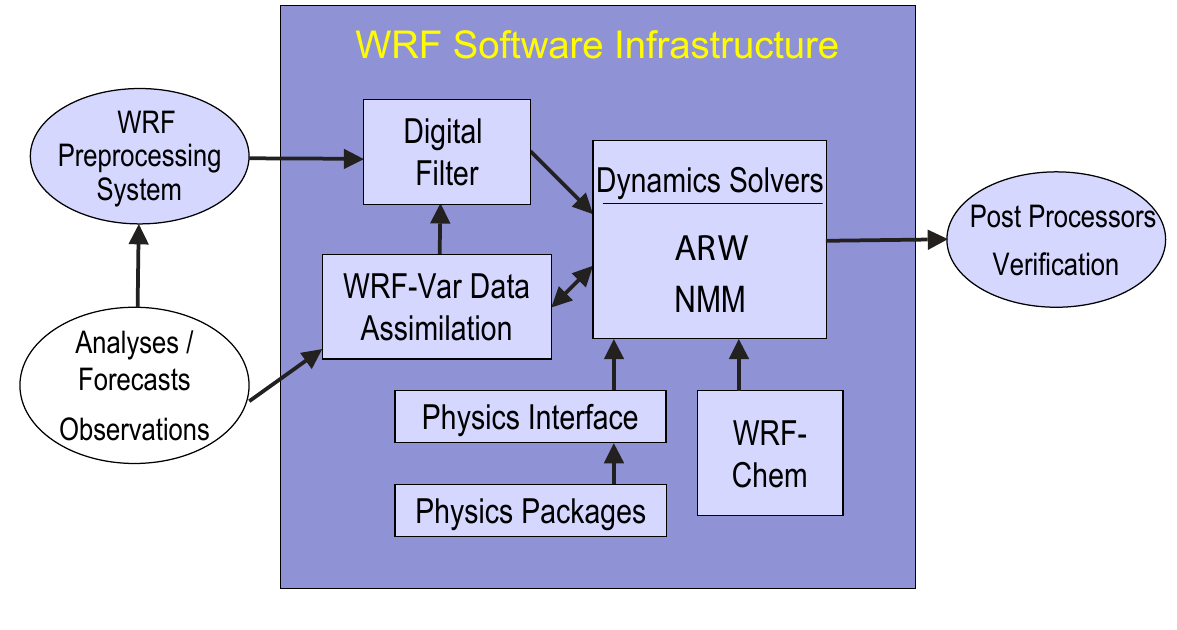
Figure 1.1: WRF system